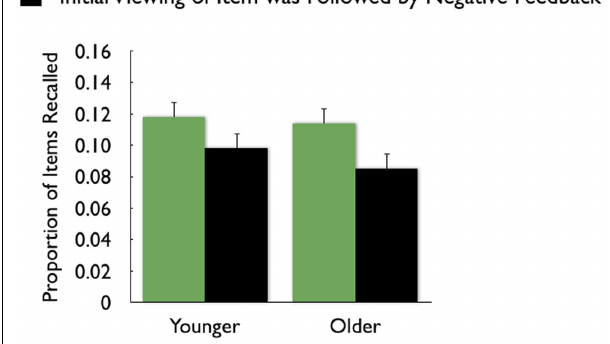
FIGURE 2 | Both younger and older adults were more likely to recall pictures that were followed by positive feedback than those followed by negative feedback.